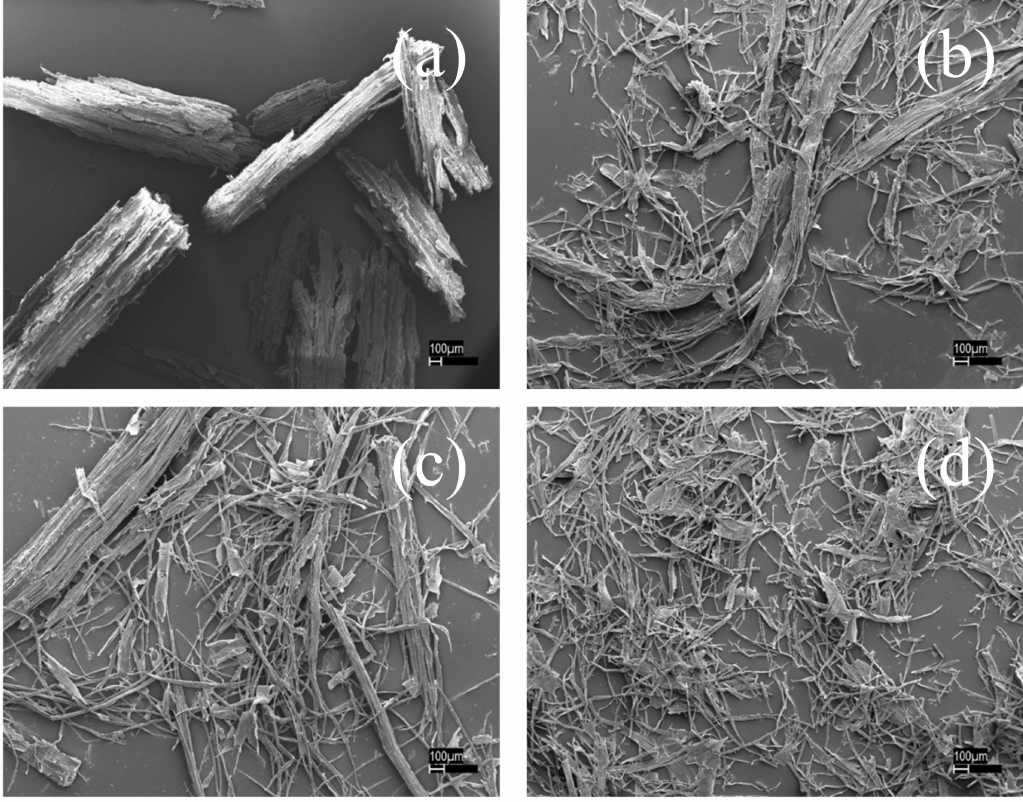
Figure 3. SEM images of poplar wood under di ff erent treatment conditions. ( a ) R; ( b ) RP; ( c ) HR and ( d ) HRP. H was autohydrolysis; P was p -toluenesulfonic acid hydrolysis; R was disk